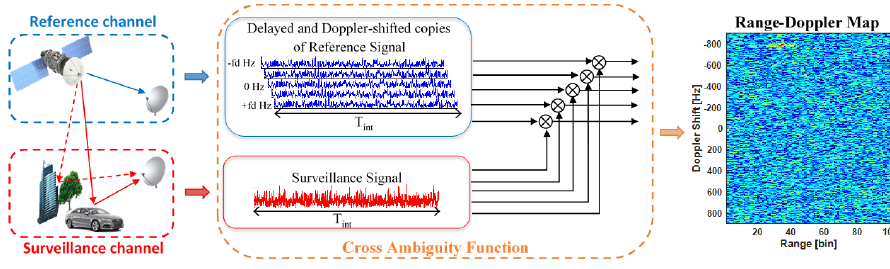
Figure 1. PR geometry scheme and operation